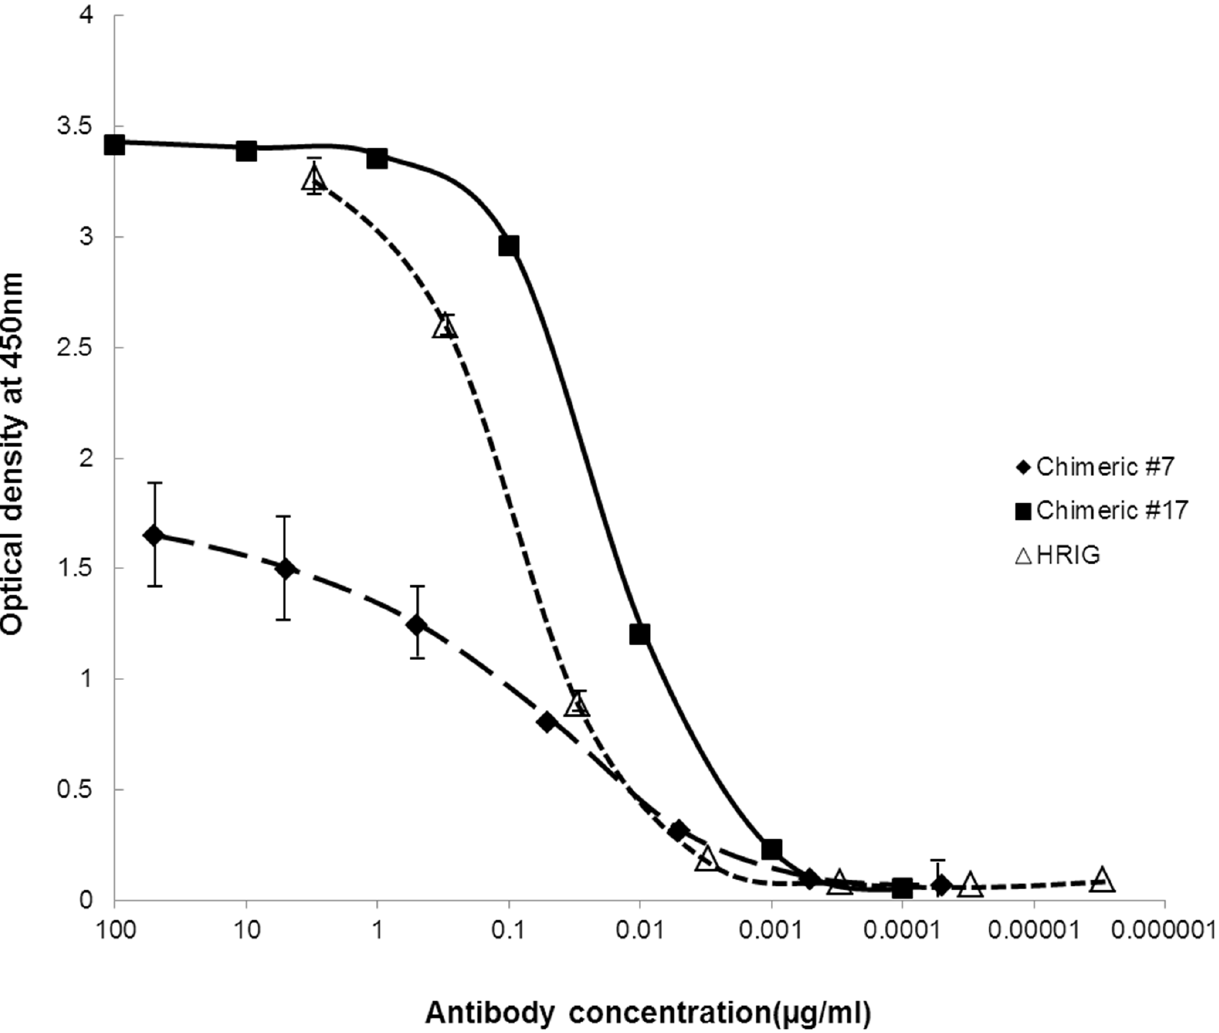
Fig 1. The affinity of chimeric MAbs #7, #17 and HRIG for RABV G protein. ChimericMAbs #7, #17 and HRIG were incubatedin plates coated with 1 μ g/mL RABV G protein, and the concentration of each antibody was indicatedon the x-axes. Bindingto the RABV G protein was expressedas an OD value detected at 450nm. The dots and lines representthe means and standard deviations, respectively, from three independentexperiments.